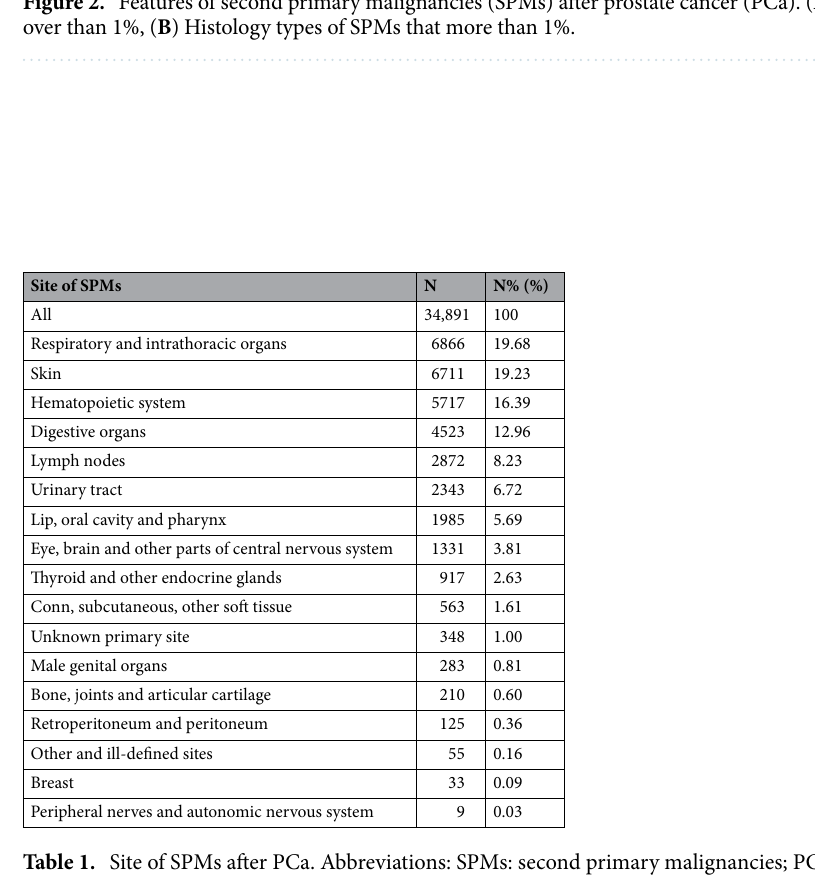
Table 1. Site of SPMs after PCa. Abbreviations: SPMs: second primary malignancies; PCa: prostate